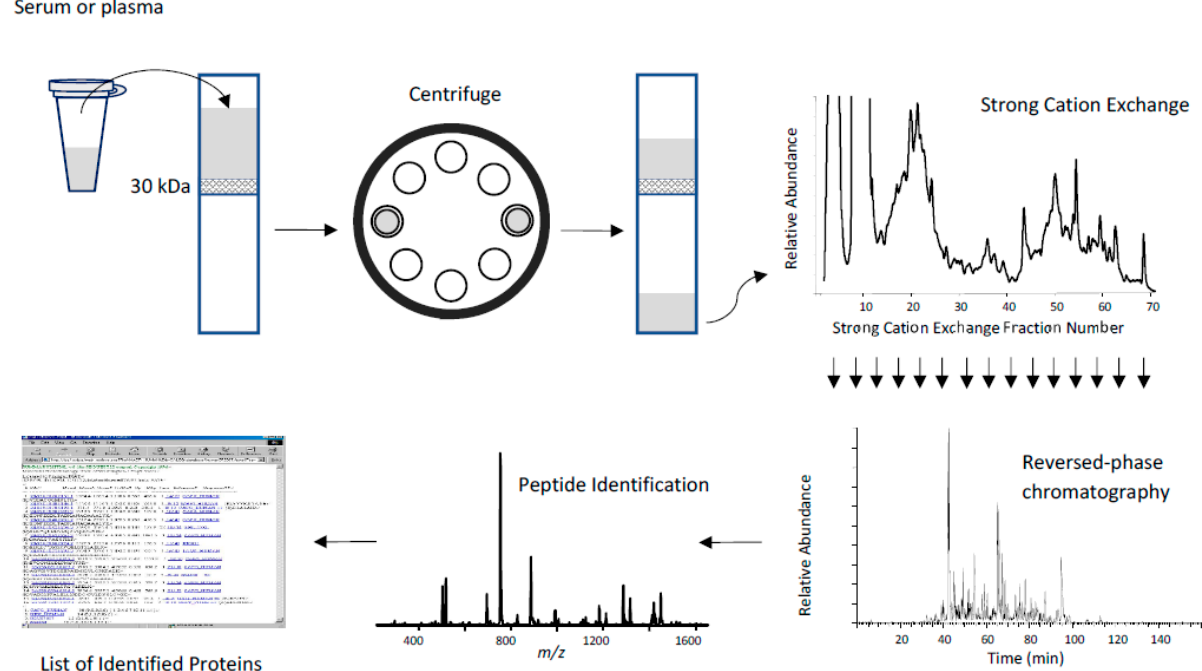
Figure 4. Analysis of a low molecular weight (LMW) serum proteome. In this analysis, serum (or plasma) is centrifuged through a 30 kilodalton (kDa) low molecular weight membrane. The flow-through is digested into tryptic peptides that are fractionated using strong cation exchange (SCX) chromatography. Fractions collected off the SCX column are separated using reversed-phase chromatography. Peptides coming off this column elute directly into the mass spectrometer, where they are analyzed to generate a list of identified proteins.